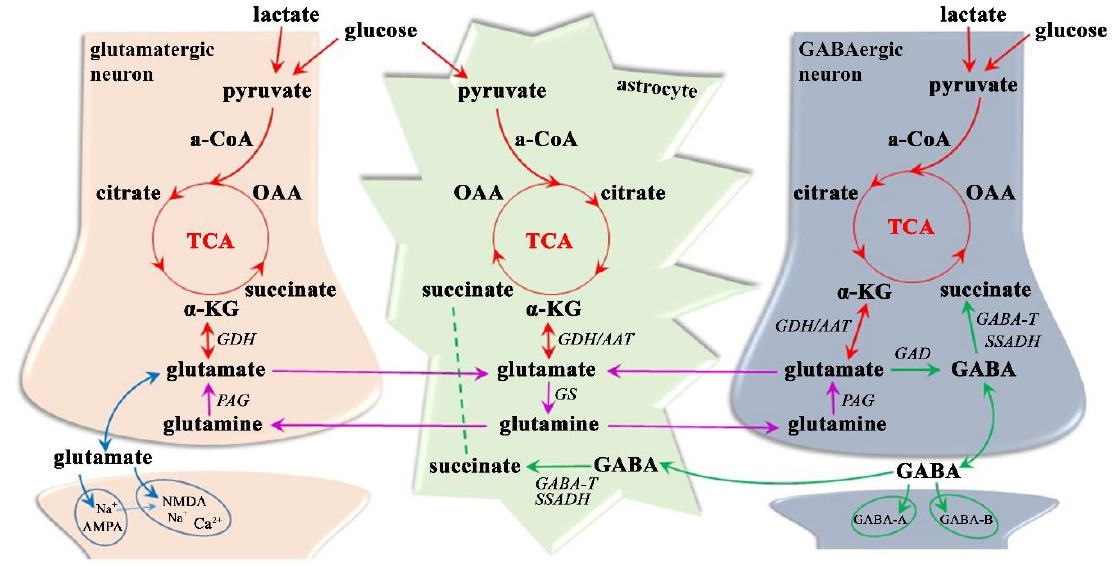
Figure 4. Schematic representation of glutamate-glutamine and γ-aminobutyric acid (GABA) metabolism. Glucose (optionally lactate) metabolism via pyruvate and acetyl coenzyme A (a-CoA) in neurons and astrocytes leads to the formation of citrate in the tricarboxylic acid (TCA) cycle resulting in the re-formation of oxaloacetate (OAA), ready for another turn of the cycle with a large amount of energy production. Citrate can be metabolized in the TCA cycle to α-ketoglutarate (α-KG), which can leave the cycle to form glutamate catalyzed by aspartate aminotransferase (AAT) or glutamate dehydrogenase (GDH). Glutamate can be combined with ammonia to produce glutamine via glutamine synthase (GS) in astrocytes and transported to neurons (both glutamatergic and GABAergic) where it forms glutamate via phosphate-activated glutaminase (PAG). After its transportation back to the astrocytes, the glutamate-glutamine cycle is complete. In glutamatergic neurons, glutamate can also be accumulated in vesicles and released as a neurotransmitter. Most glutamatergic activity stimulates α-amino-3-hydroxy-5-methyl-4-isoxazole propionic acid (AMPA) receptors, which are permeable to Na + ions. Under persistent stimulation, the voltage-dependent bound Mg 2+ ion is removed from the N-methyl-D-aspartate (NMDA) receptor enabling an influx of both Na + and Ca 2+ . However, cytosolic glutamate might be reuptaken by glutamatergic neurons and reconverted to aspartate during the transamination of glutamate to α-KG catalyzed by glutamate dehydrogenase (GDH). Metabolism of α -KG is linked to the TCA cycle. In addition, glutamate is the main precursor of GABA, whose synthesis is based on glutamate decarboxylase (GAD) in GABAergic neurons. In neurons and astrocytes, GABA can be transaminated via GABA-transaminase (GABA-T) to succinic-semialdehyde and further oxidized by succinate semialdehyde dehydrogenase (SSADH) to succinate, which is also an intermediate of the TCA cycle. Moreover, GABA is a major inhibitory neurotransmitter that influences both ionotropic GABA-A and metabotropic GABA-B receptors, causing the inhibition of